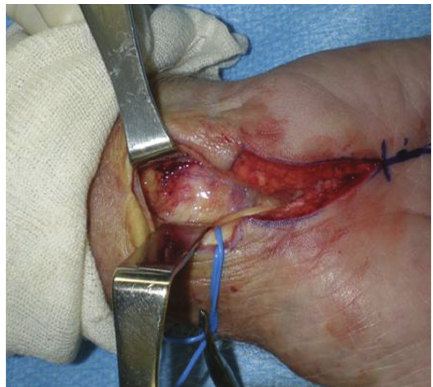
F 4: e le hand with marked �uid and proliferation of the synovial sheaths in the carpal